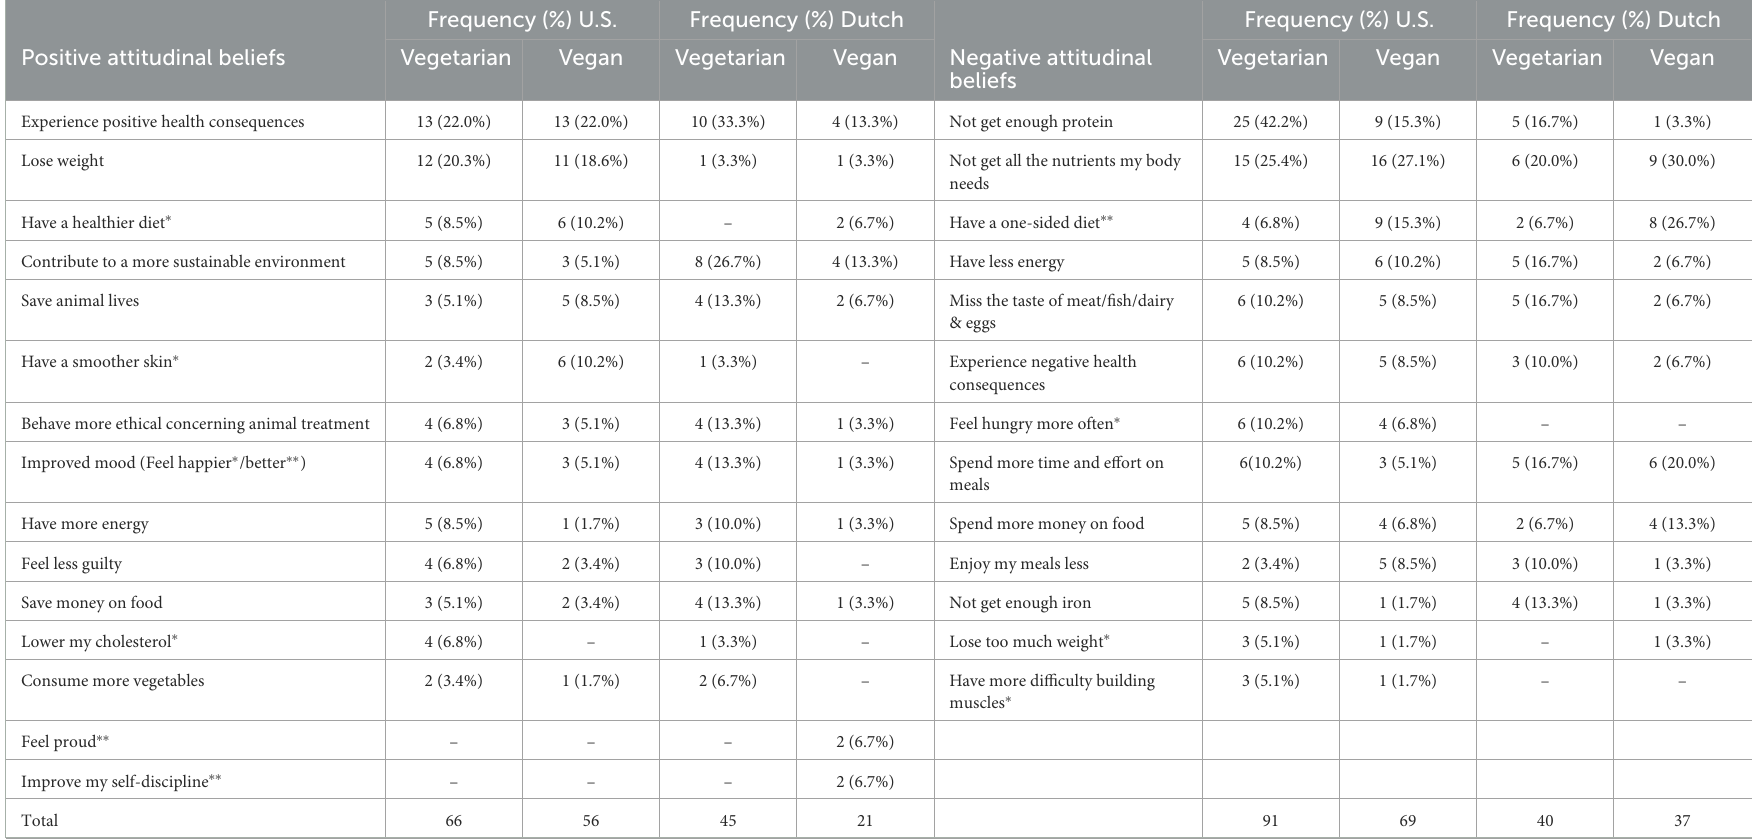
TABLE 2A Results belief elicitation questionnaire: most frequently mentioned (% of participants mentioned) attitudinal beliefs U.S. and Dutch sample. Frequency (%)